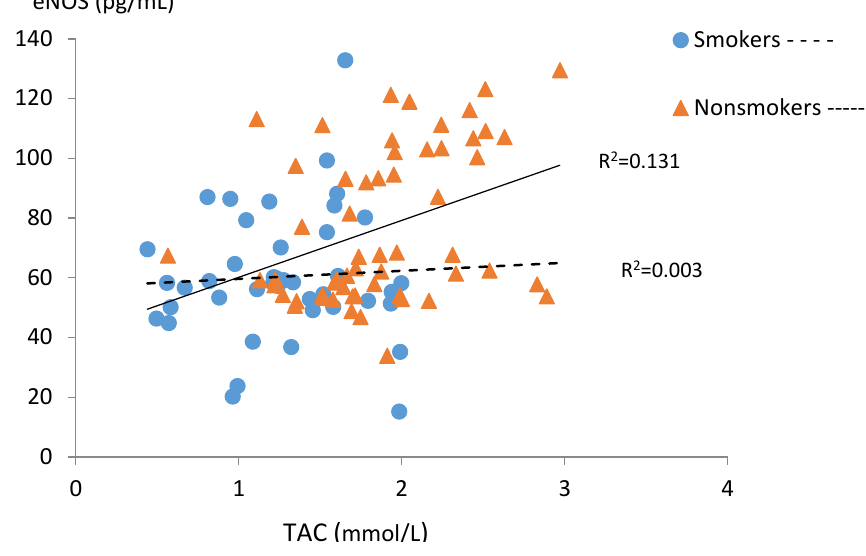
Figure 4. Correlations between serum eNOS and TAC levels in the subgroups of smoking (n = 42) and non-smoking pregnant women (n = 57).